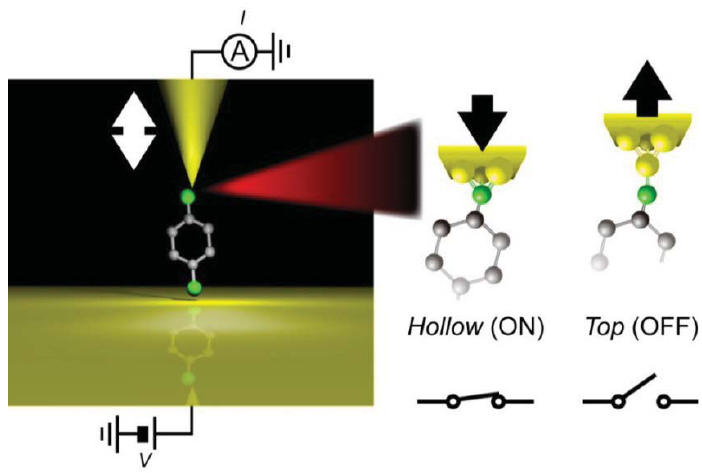
Figure 7. Mechanically-controlled conductance switching of single-molecule junctions. Binary conductance switching occurs synchronous to the sinusoidal modulation of the tip motion that repeatedly deforms metal-molecule contact structure between two stable configurations such as hollow-to-top Au-thiol bonding